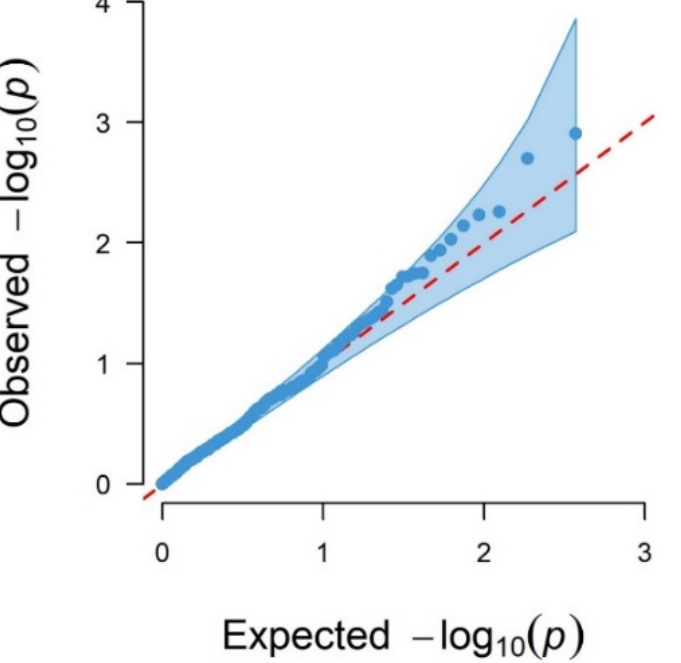
( p -values) (blue dots) and expected − log ( p -values) (red 10 10